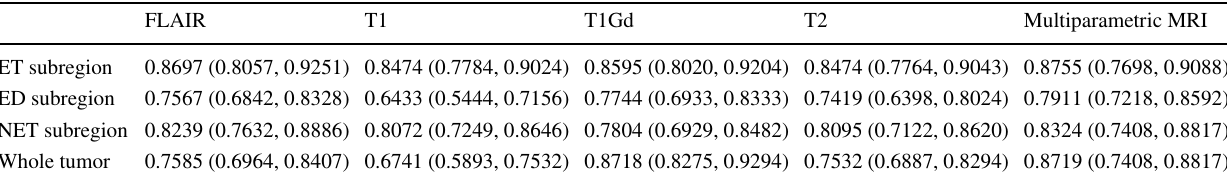
Table 5 Performance comparisons of multivariate classifiers among the tumor subregions and the whole tumor FLAIR T1 T1Gd T2 Multiparametric